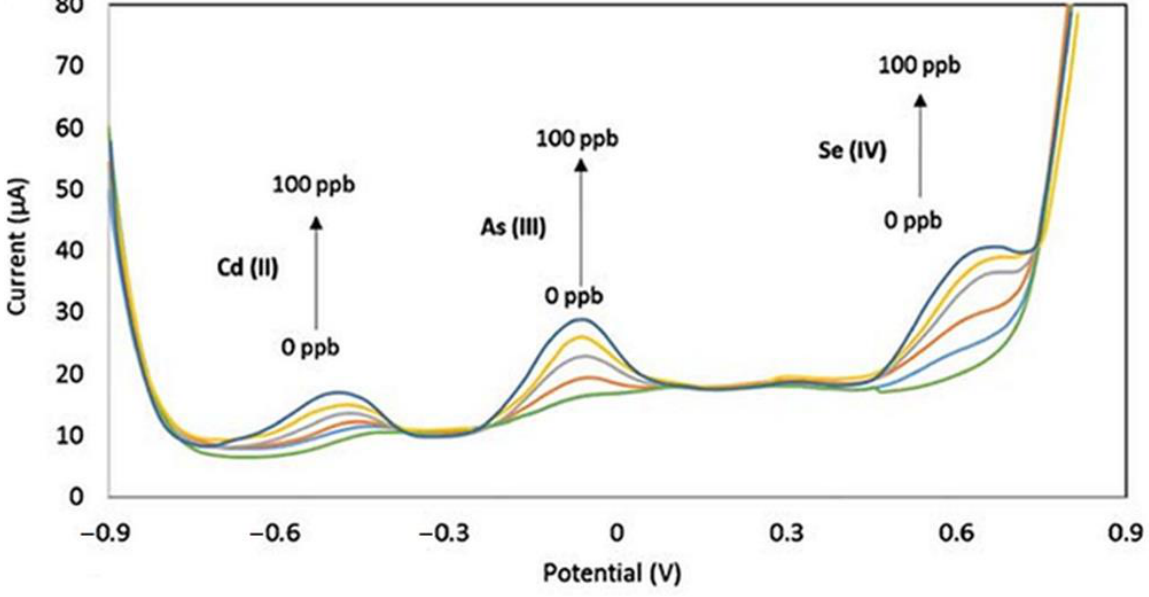
Figure 2. SWASV response of AuNS-modified SPCE electrode for simultaneous detection of Cd(II),As(III)and Se(IV) in concentration range from 0 to 100 ppb (around 10 −6 mol L −1 ) [40]. Table 1. Comparison of analytical performance of electrochemical sensors for the detection of selenium. Method 1 /